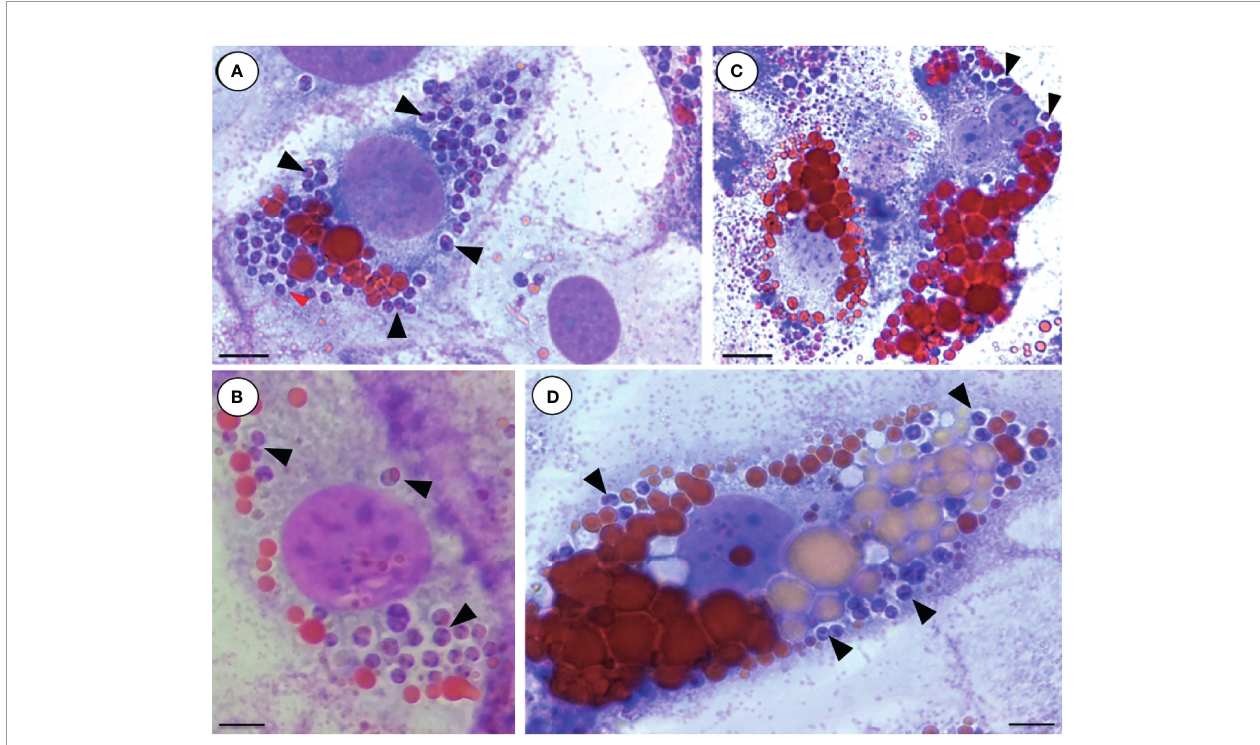
FIGURE 3 | Infection of 3T3-Ad with L. (V.) braziliensis . 3T3-Ad presenting reduced (A, B) or increased number of lipid droplets (C, D) were infected with axenic amastigotes of L. (V.) braziliensis for 24 h (MOI=20) and stained with Giemsa (purple nuclei and purple amastigotes) and Oil-Red O (lipid droplets in red). Arrowheads point to single amastigotes and individual PVs. Bars (A) = 6 µm; (B, D) = 5 µm, (C) = 8